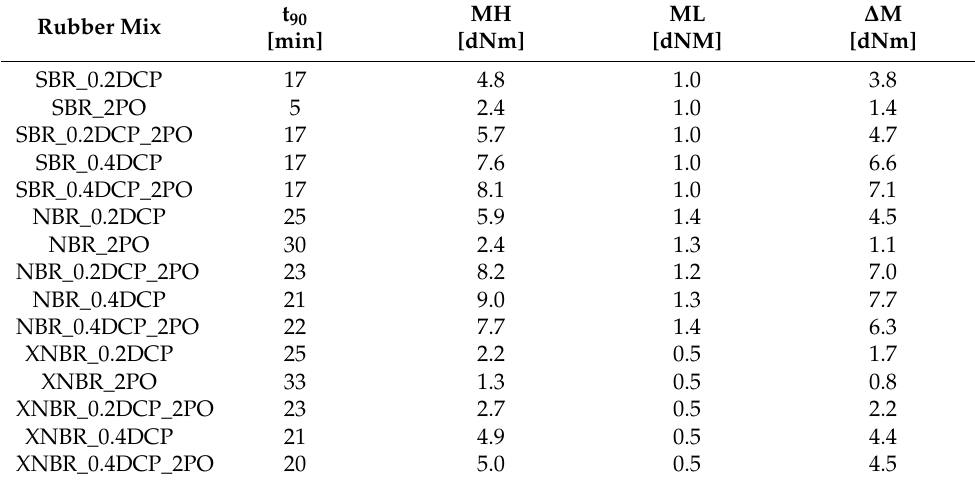
Figure 4. Crosslinking kinetics of the compounds based on carboxylated acrylonitrile-butadiene rubber (XNBR). Table 2. Curing parameters of the rubber compounds